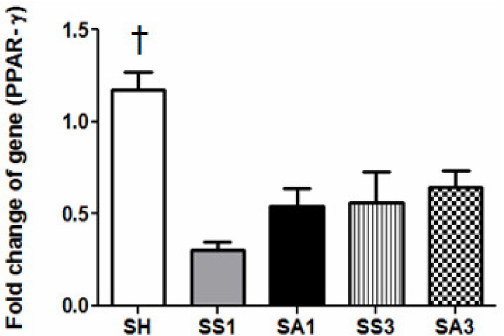
Figure 4. Messenger RNA expressions of PPAR- γ in epididymal fat tissues. SH, sham group without a sleeve gastrectomy (SG) ( n = 8); SS1 and SS3, saline groups sacrificed on day 1 or 3 after the SG; SA1 and SA3, arginine groups sacrificed on day 1 or 3 after the SG. n = 10 for each SG group. Values are presented as the mean ± SEM. A two-way analysis of variance (ANOVA) with the Bonferroni post-hoc test was used to analyze differences among the SH and gastrectomy groups. † Significantly differs from the gastrectomy groups ( p <